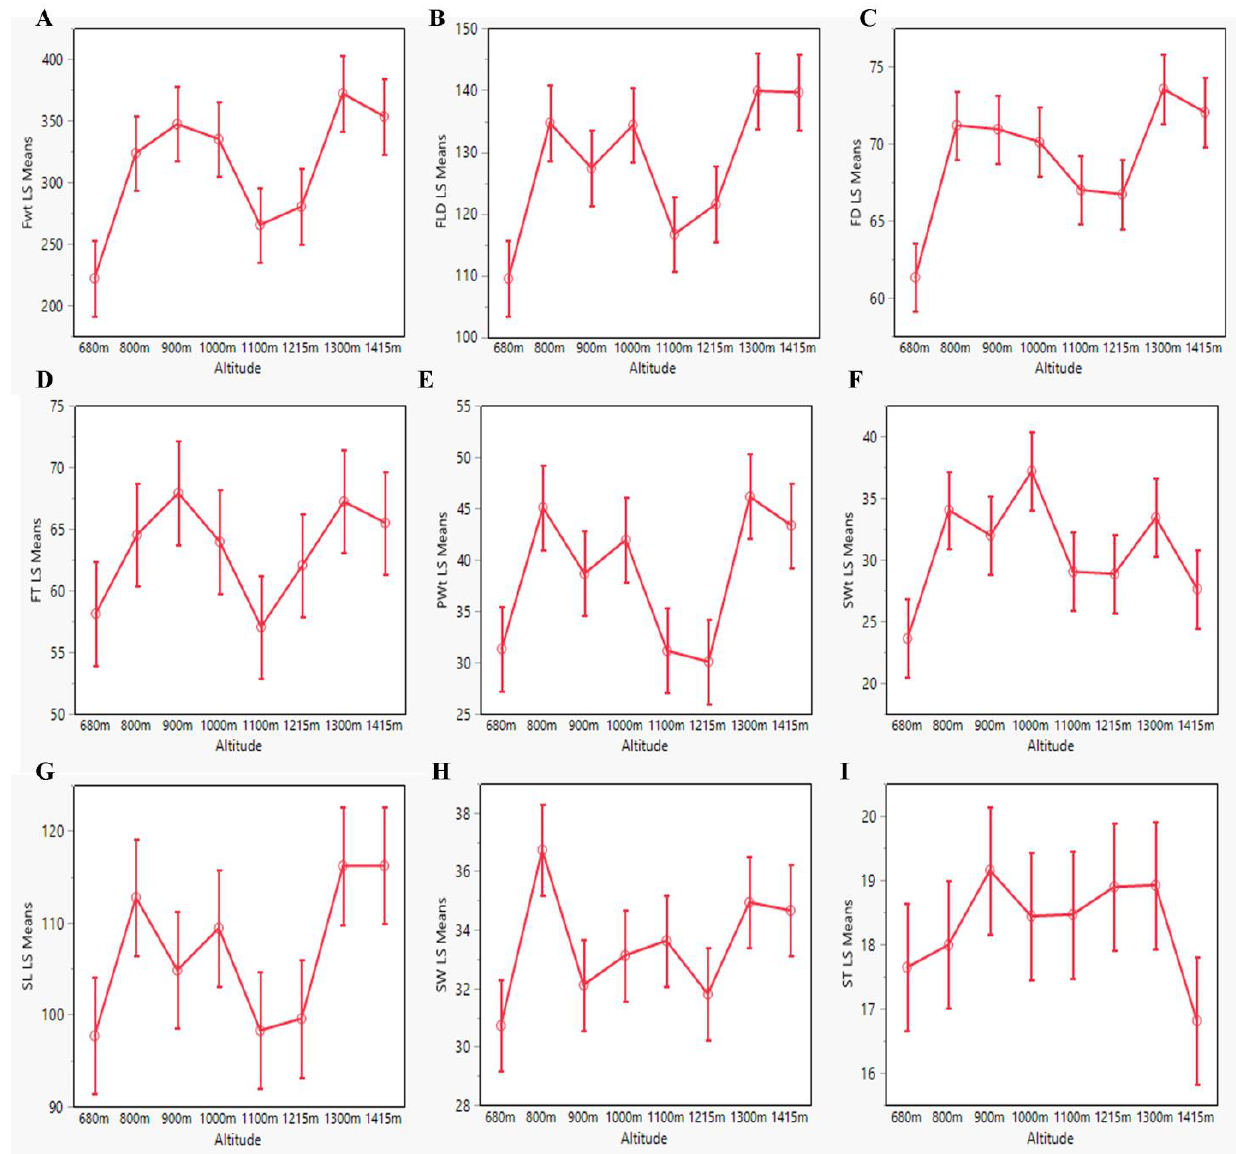
Figure 2. The least-square means for morphological traits: ( A ) Fruit weight (Fwt); ( B ) Fruit longitu- dinal diameter (FLD); ( C ) Fruit transversal diameter (FD); ( D ) Fruit thickness (FT); ( E ) Peel weight (Pwt); ( F ) Seed weight (Swt); ( G ) Seed length (SL); ( H ) Seed width (SW); and ( I ) Seed thickness (ST).